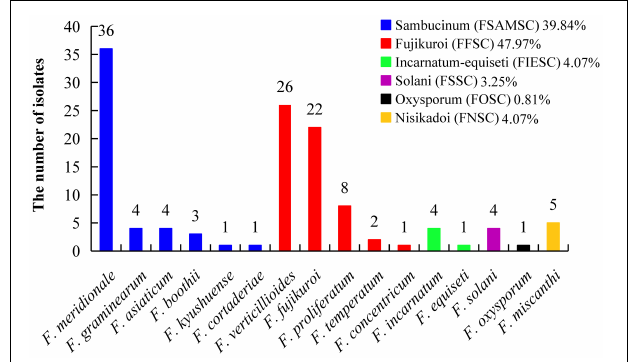
FIGURE 5 | Classification of 123 Fusarium isolates based on sequence analysis of the TEF-1 α gene.